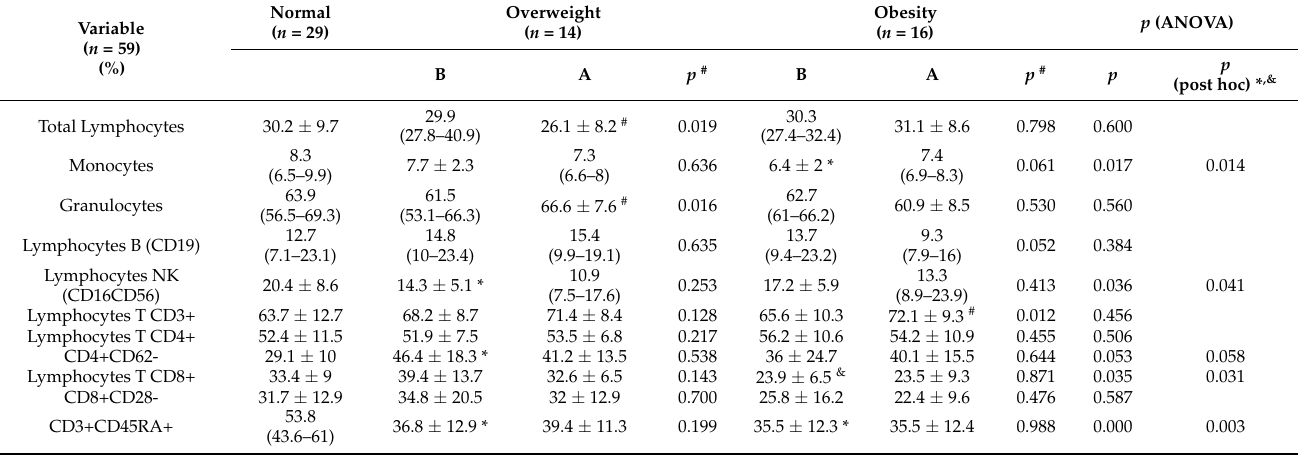
Table 3. Leukocyte distribution before and after of dietary plan according to